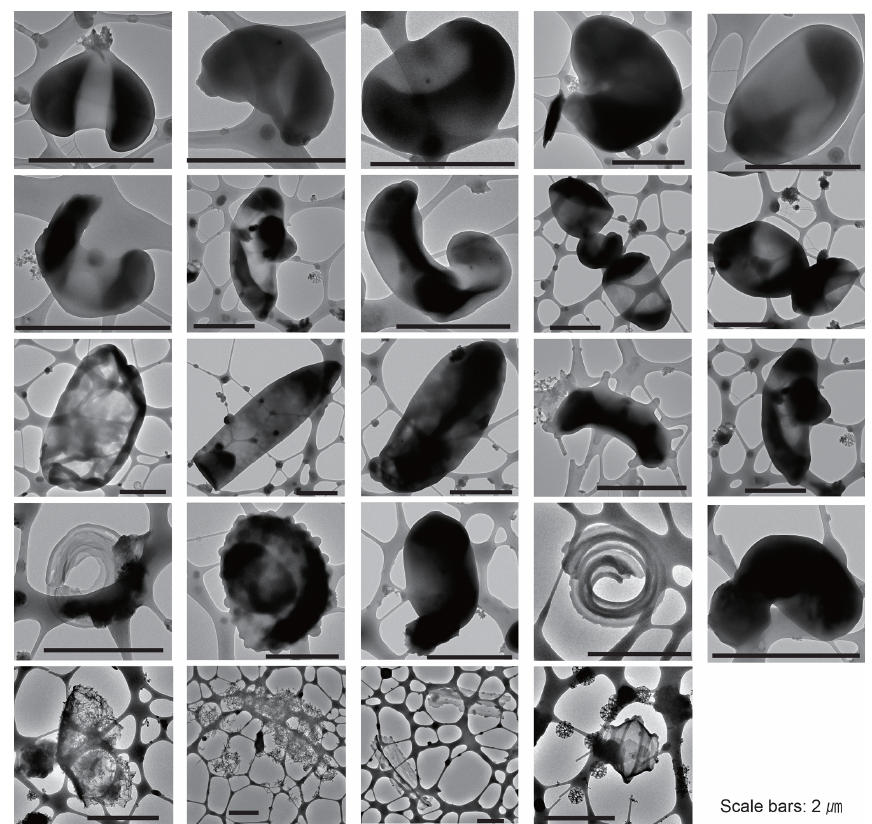
Figure 9. Examples of TEM images of PBA and the relevant particles. The TEM images were obtained from samples collected during other (background) periods (09:00, 7 February; 15:00, 10 February; 00:00, 27 February; 03:00, 15 March 2014; 09:00, 18 March 2014). Brochosome particles, which originate from leafhoppers (Wittmaack, 2005), were abundant in some samples (e.g., bottom right image) and were included in the “other” category because they do not contain P. Some particles were too fragile to analyze the composition (e.g., three images from the bottom left), although their shapes imply that they have biological sources. As these PBA particles were observed under vacuum, they can have inflated shapes when observed in ambient conditions.